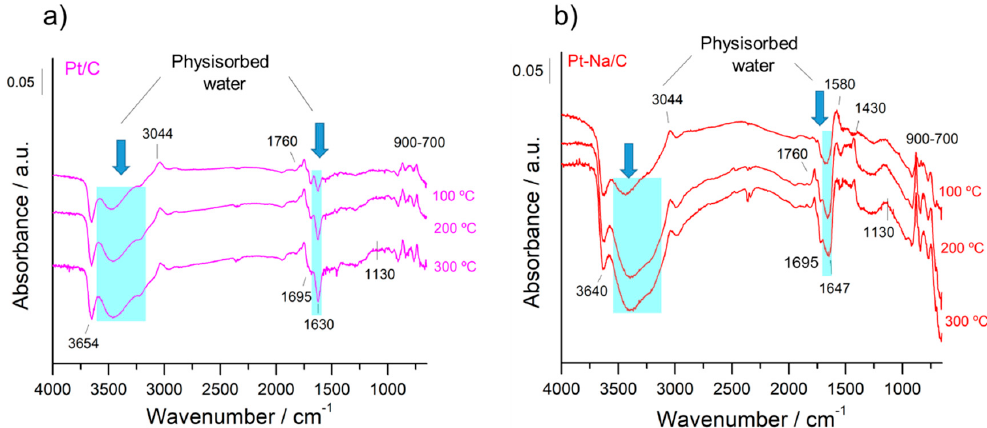
Figure 5. Evolution of difference DRIFT spectra in function of the temperature under activation pre-treatment for the carbon supported catalysts; ( a ) Pt/C, and ( b ) Pt–Na/C. The reference spectrum was recorded prior to activation at RT.